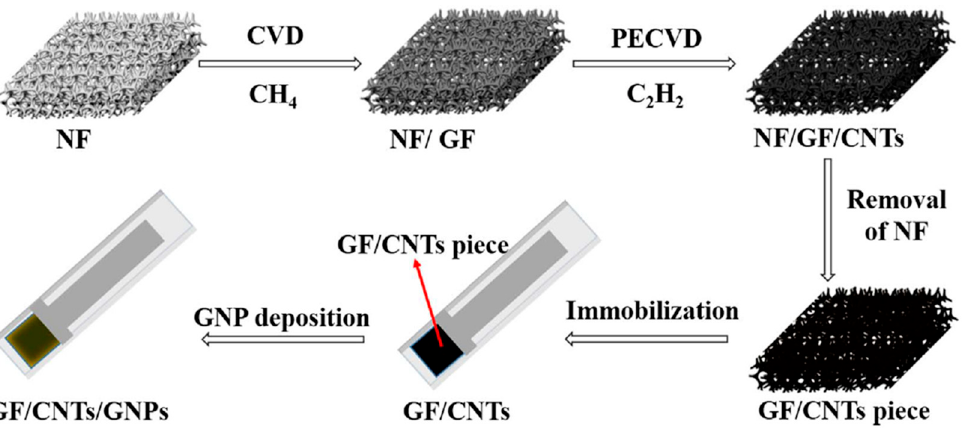
Figure 10. Schematic illustration of GF/CNTs/GNPs preparation for uric acid detection biosensor. Image reproduced with permission from [207]. Copyright 2017 Elsevier.